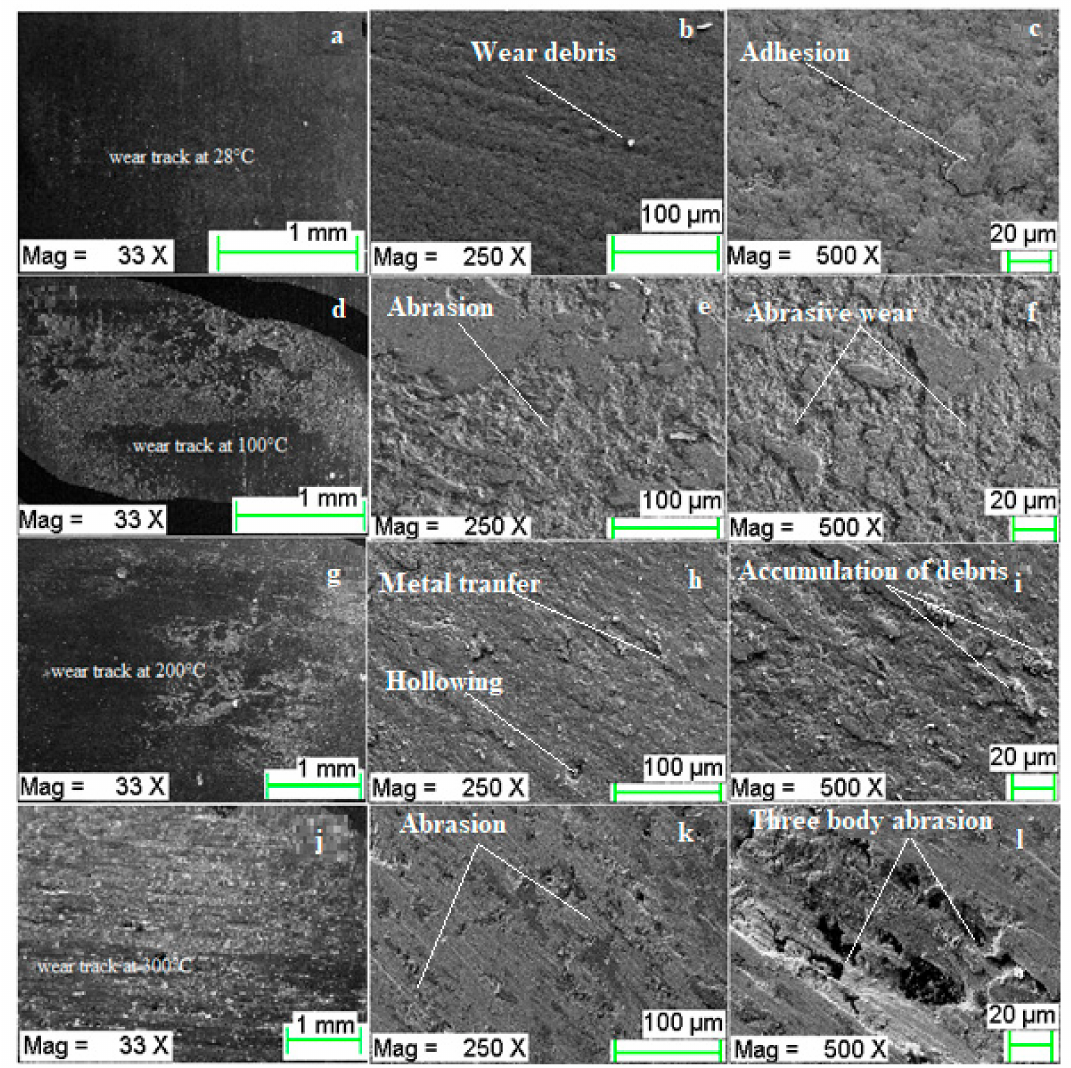
Figure 9. Worn surface morphology of CrN at di ff erent test conditions: ( a – c ) wear track at 28 ◦ C and 10 N load, ( d – f ) wear track at 100 ◦ C and 20 N load, ( g – i ) wear track at 200 ◦ C and 30 N load, ( j – l ) wear track at 300 ◦ C and 40 N